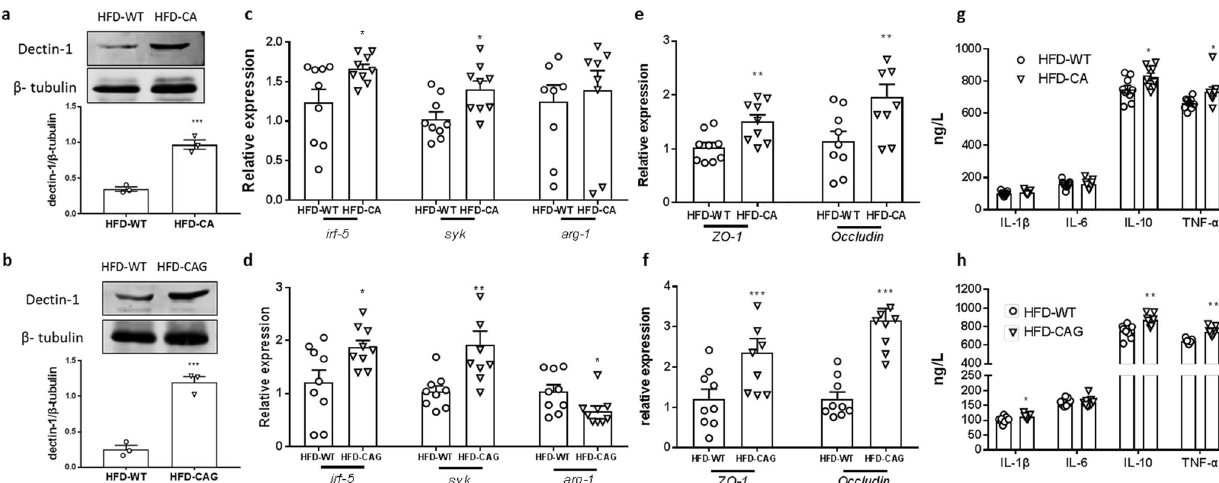
Fig. 6 CAG induce insulin resistance though the activation of dectin-1 pathway. a , b The colon dectin-1 level of the C. albicans -treated or CAG-treated mice ( n = 3 mice per group), c , d The expression of irf-5 , syk and arg-1 in colon, e , f The expression of ZO-1 and occludin in colon, g , h The serum levels of IL- 1 β , IL-10, IL-6, and TNF- α . Data are presented as the mean ± standard error of the mean (SEM); n = 9 mice per group. Statistical analysis was done using one-way ANOVA followed by the Tukey post hoc test. * P < 0.05; ** P < 0.01 and *** P < 0.001 vs HFD-WT group.